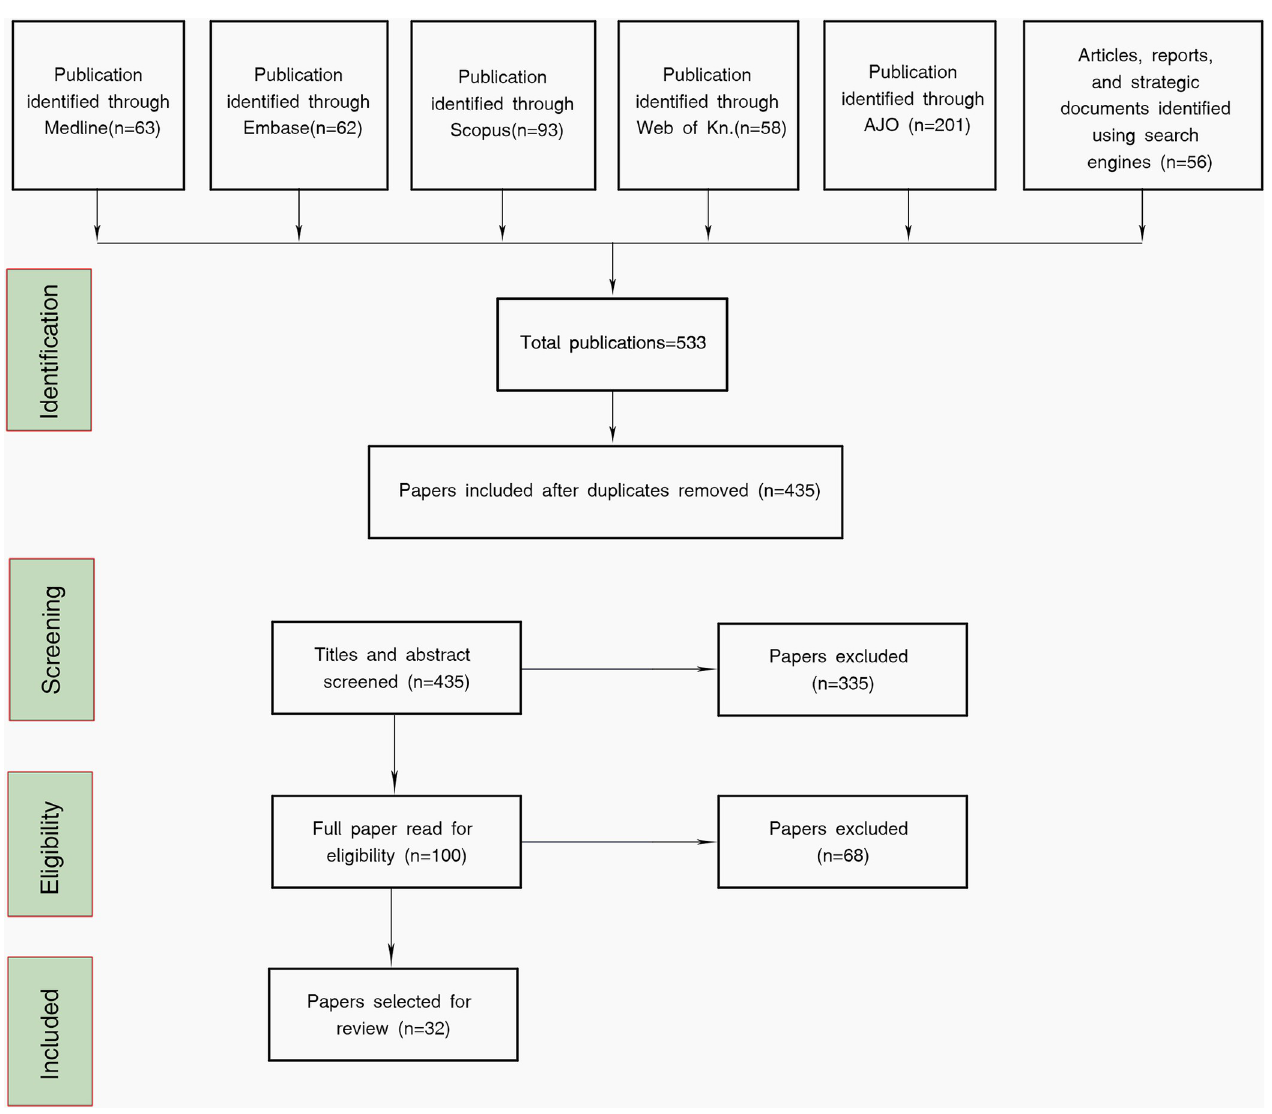
Fig 2. Search results and study selection